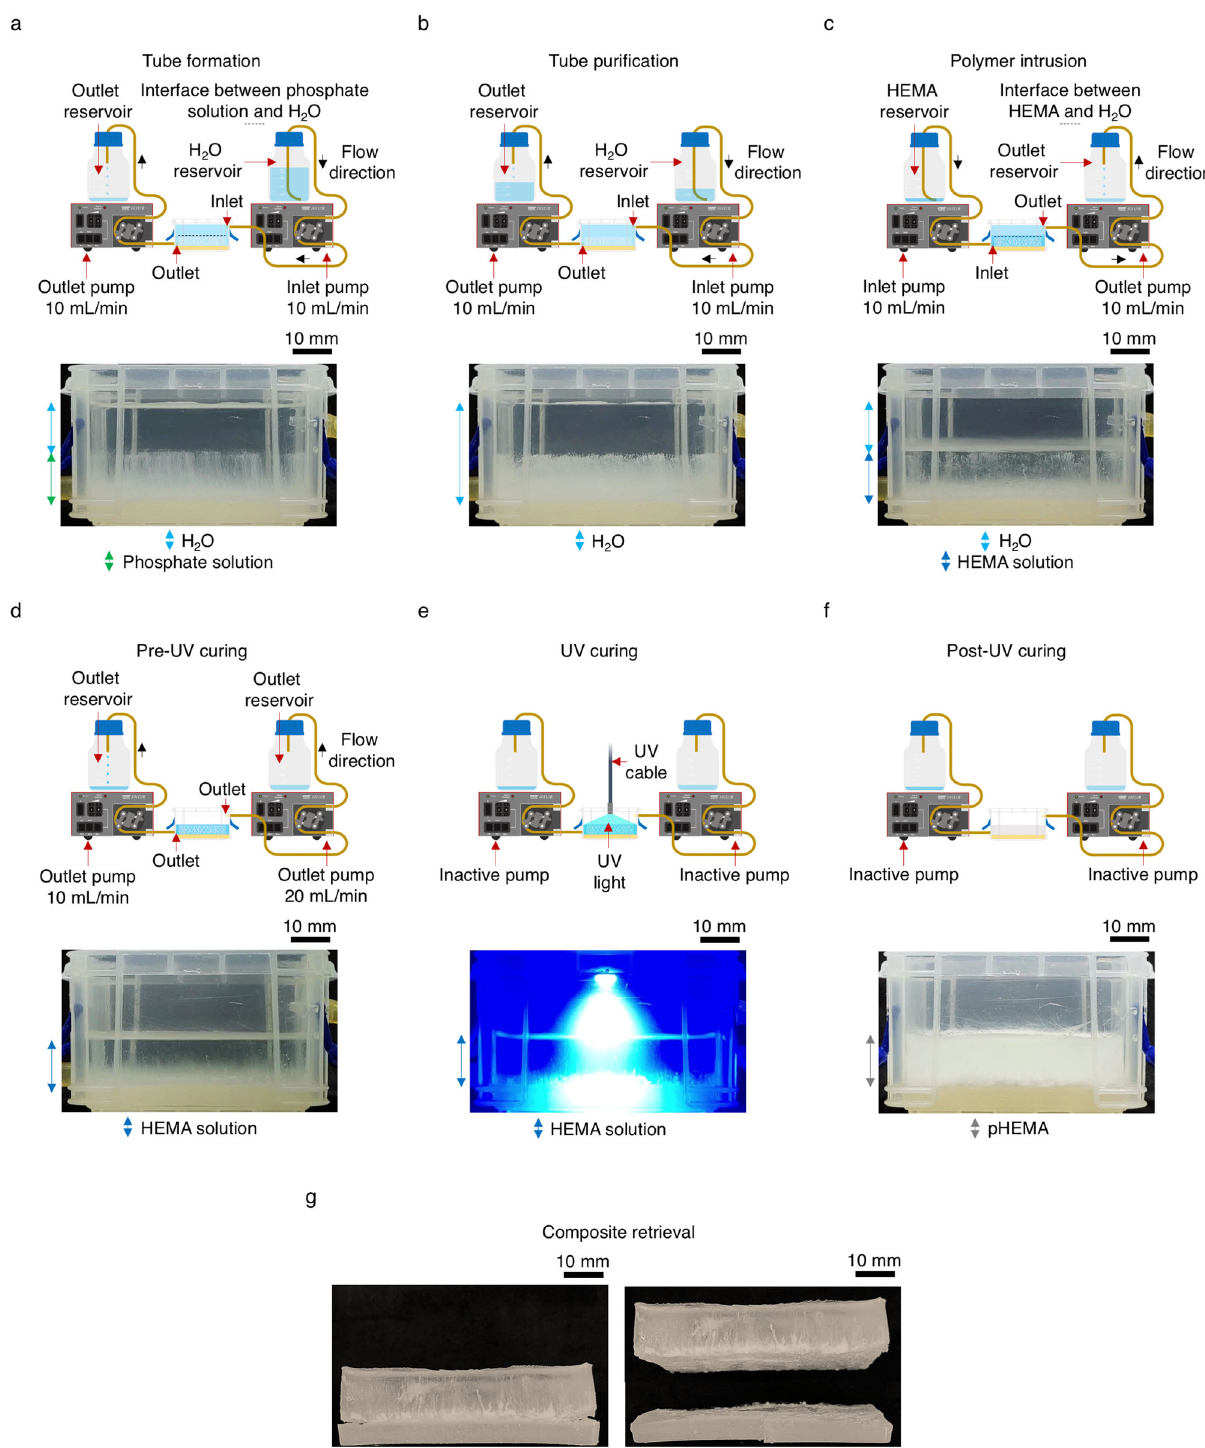
Fig. 3 Fabrication of a chemobrionic composite incorporating self-assembled chemical garden structures. a Displacement of phosphate solution with H 2 O performed during the formation of calcium phosphate tubes. When the tips of the tubes met the established H 2 O layer, displacement was halted. b Structures puri fi ed in situ with a volume displacement (VD) ratio of 10:1 (H 2 O to phosphate solution). c Displacement of H 2 O with 2-hydroxyethyl methacrylate (HEMA) performed following puri fi cation. d Excess HEMA was drained until level with the tips of the growth halted calcium phosphate tubes. e UV irradiation of the liquid exchange unit and its contents. f UV irradiation encased the calcium phosphate tubes in a matrix of poly(2-hydroxyethyl methacrylate) (pHEMA). g Recovered contents of the liquid exchange unit. The composite was retrieved by peeling away the hydrogel